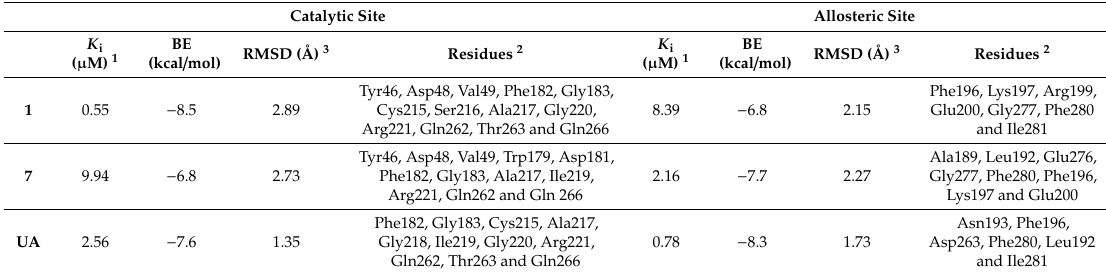
Table 4. Results of the dockings analyses.